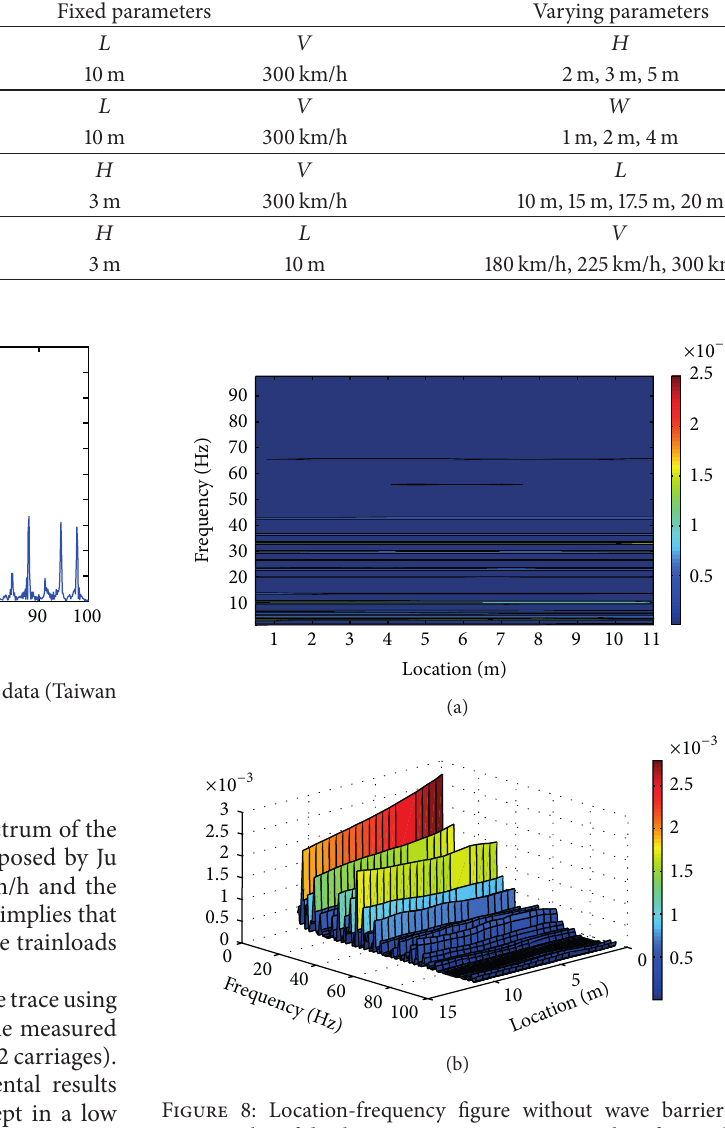
Figure 8: Location-frequency figure without wave barrier (a) contour plot of displacement spectrum on ground surface and (b) surface plot of displacement spectrum on ground surface (Poisson’s ratio ] = 0.25; train speed 𝑉 = 300